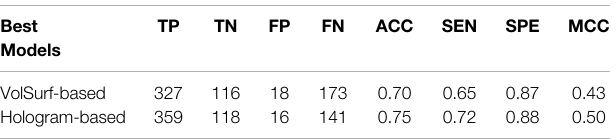
TABLE 5 | Performance of the best models on the external validation